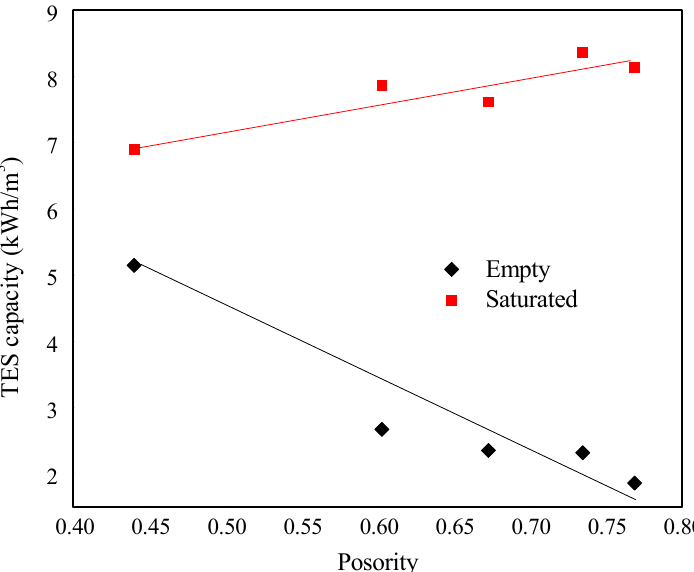
Figure 12. Influence of porosity on the thermal energy storage (TES) capacity of empty and satu- rated bricks.